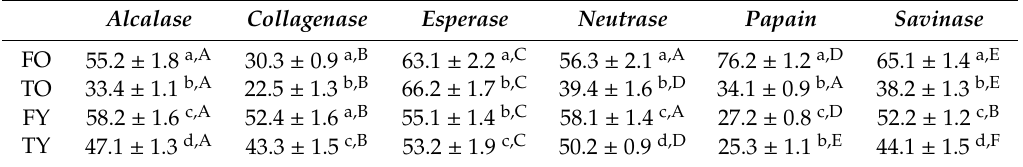
For each enzyme, significant differences among bones ( p < 0.05) are indicated by different superscript lowercase letters; for each bone, differences among enzymes ( p < 0.05) are indicated by different superscript capital letters.